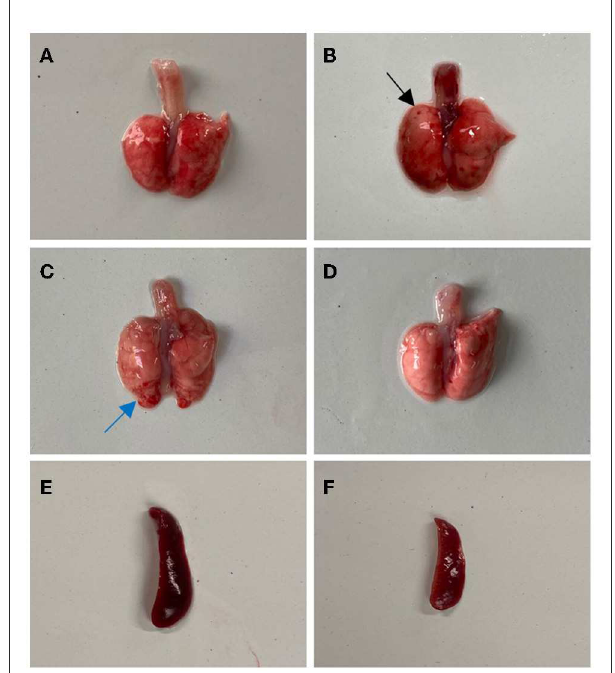
FIGURE3 Gross lesions in BALB/c mice after infection with BO/YB24/17/CH strain. (A) Lung congestion (the 3th day after infection). (B) Lung hyperemia with sporadic petechial, indicated with black arrow (the 11th day after infection). (C) Pulmonary hemorrhage and lobular atrophy, indicated with blue arrow (the 15th day after infection). (D) Lung of the control group. (E) Spleen swelling (the 5th day after infection). (F) The spleen of the control group.